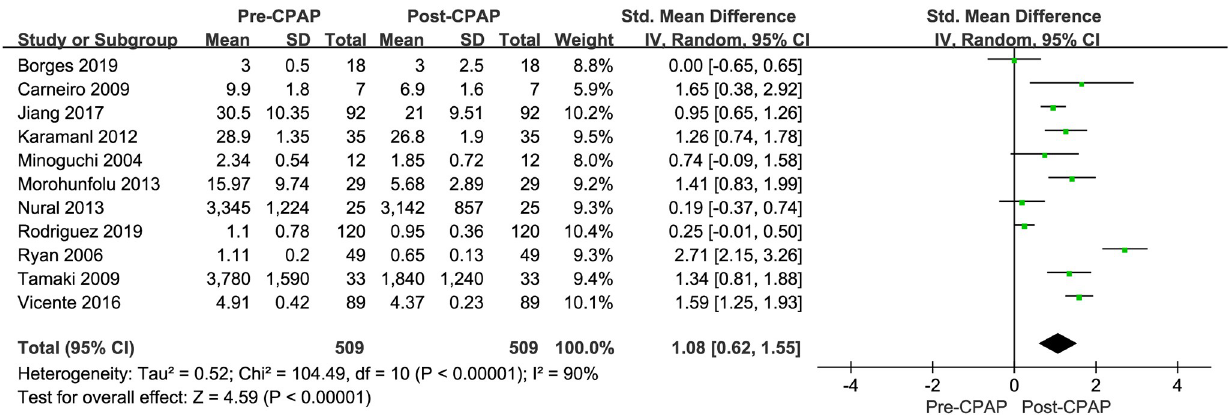
was performed to investigate the differences between TNF- α level and OSAHS. Furthermore, sensitivity analysis revealed that the overall results remained unchanged when any single study was excluded or REM was converted to FEM. Therefore, we believe the data obtained from the present study are reliable. which is consistent with our findings, as CPAP therapy lowers TNF- α levels in OSAHS during nocturnal hypoxia. Various studies in animal models of OSAHS have indicated that TNF- α can stimulate cells to produce IL-1 and IL-17, which ultimately leads to the recruit- ment of neutrophils and plays an important role in the deterioration of OSA at night [27]. Similarly, Minoguchi et al . [20] described that deterioration of sleep quality due to repeated apnea-associated hypoxia is associated with increased TNF- α production in OSA patients. In addition, NF- κ B signaling is important in stimulate TNF- α in OSA [20]. Studies indi- cated that TLR2/TLR4 activation had been associated with the release of TNF- α from mono- cytes in OSA patients through NF- κ B signaling [21]. Moreover, body mass index (BMI)